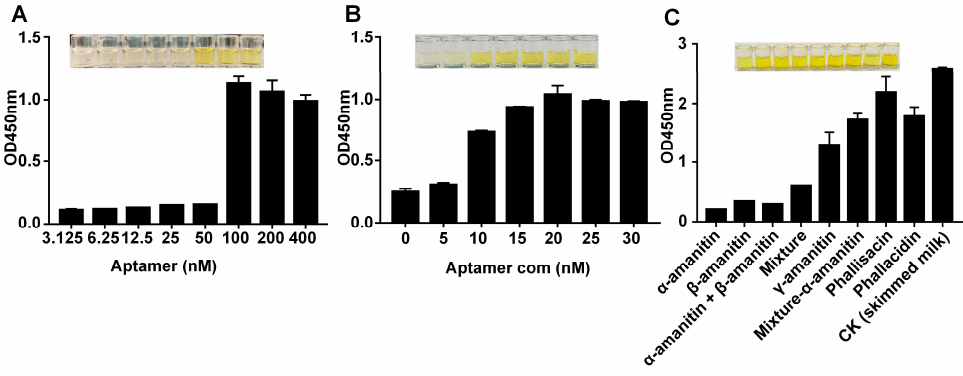
Figure 5. Optimizing the MELISA to detect α -amanitin. ( A ) Optimizing the aptamer concentration. The aptamer concentrations were 3.125, 6.25, 12.5, 25, 50, 100, 200, and 400 nM, in that order. ( B ) Optimizing the complementary chain concentrations. The complementary chain concentrations were 0, 5, 10, 15, 20, 25, and 30 nM, in that order. ( C ) Specificity of the experimental methods. Method specificity was determined with α-amanitin and other non-target substances, including β-amanitin, γ-amanitin, phallacidin, and phallisacin.